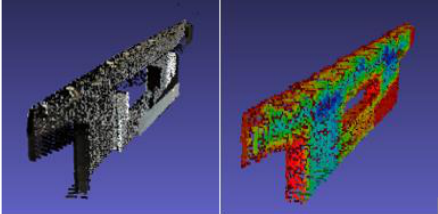
Figure 10. The occlusion on the surface of pier (Left) and the quality heat map after Hausdorff distance simpling (Right).